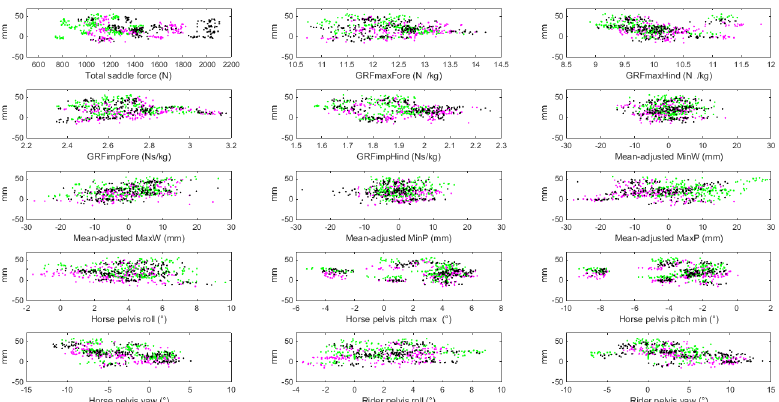
Fig 2. Evaluated fixed effect variables. Descriptive plots of independent fixed effect variables on the x-scale versus the outcome variable, lateral movement of the saddle in relation to the horse spine in mm, on the y-scale. Green is rising steps in rising trot, magenta is sitting steps in rising trot and black is sitting trot. The number of observations is 620, except for the rider kinematics where n = 590. Horse pelvis roll; positive rotation is away from the supporting hindlimb side Horse pelvis pitch; positive rotation is clockwise viewed from the right (i.e. tail up) Horse pelvis yaw; positive rotation is away from (i.e. tail towards) the supporting hindlimb side Rider pelvis roll; positive rotation is away from the supporting hindlimb side Rider pelvis yaw; positive rotation is away from the supporting hindlimb side.